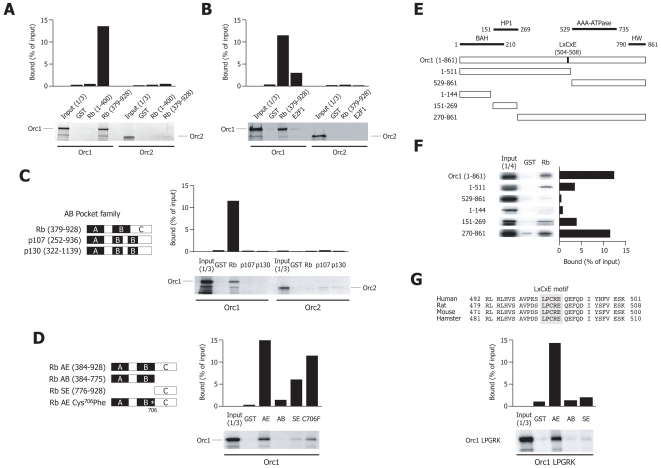
Orc1 specifically interacts with Rb in vitro.(A) GST pull-down experiment performed by incubating GST alone or GST fused to the N-terminus (aa. 1–400) or the C-terminus (aa. 379–928) of Rb, immobilized on gluthatione-agarose beads, with in vitro translated [35S]-labelled Orc1 or Orc2 proteins. The upper panel shows the quantification of the [35S]-labelled protein after in vitro binding. The amount of radioactivity bound to the beads is indicated as a percentage of the input material. The lower panel shows the autoradiography. The Input lanes contain the labelled proteins prior to binding. A representative experiment of at least 3 performed is shown. (B) GST pull-down experiment performed by incubating GST, GST-Rb (379–928) or GST-E2F1 fusion proteins on gluthatione-agarose beads with in vitro translated [35S]-labelled Orc1 or Orc2. The results are shown as in panel (A). (C) Binding to Orc1 is specific for Rb. The scheme on the left side shows the conserved A/B pocket domains in the three members of the RB family, which were used as GST fusion proteins. The figure on the right side, shows the result of a GST pull-down experiment performed with these proteins, and in vitro translated Orc1 and Orc2. “Rb” for short corresponds to the C-terminus of Rb (aa. 379–928). (D) Binding to Orc1 requires the C-terminal region of Rb. The scheme on the left side of the figure shows the Rb truncated or mutated proteins used for mapping the domains required for binding to Orc1 (AE, containing the A, B and C pockets; AB, A and B pockets only; SE, C pocket only; AE Cys706Phe, which does not bind LxCxE proteins). These proteins were obtained as GST fusions and used for the GST pull-down experiment shown on the right side of the panel. (E) Schematic representation of the main functional domains of the Orc1 protein. BAH, bromo-adjacent homology domain; HP1, HP1 binding domain; AAA, ATPase domain; HW, putative DNA binding site. The fragments of Orc1 subsequently tested by in vitro GST pull-down are indicated by the corresponding amino acids on the left side. (F) GST pull-down experiment performed with the Orc1 fragments indicated in (E), labelled by in vitro translation, and challenged to GST or GST-Rb proteins. “Rb” for short corresponds to the C-terminus of Rb (aa. 379–928). (G) Sequence alignment showing the conserved LxCxE motif found in the Orc1 subunit of human, rat, mouse and hamster (upper part), and GST pull-down experiment performed with the in vitro translated Orc1 LPGRK protein (mutated in the LxCxE motif of Orc1) and the GST-fusion proteins AE, AB and SE (lower part).